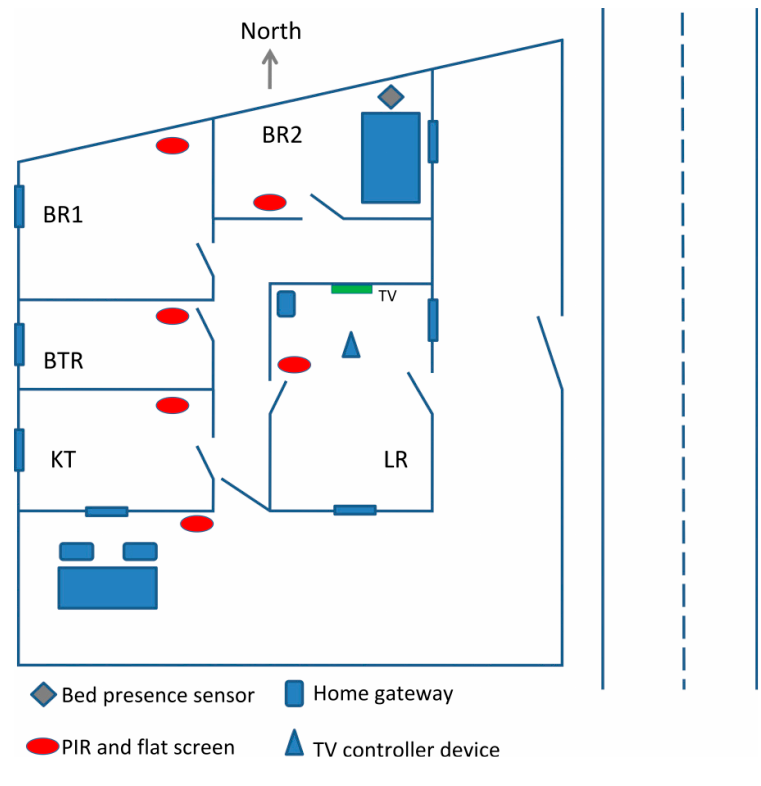
Figure 5. The home (LR-living room, BR-bedroom, BTR-bathroom,